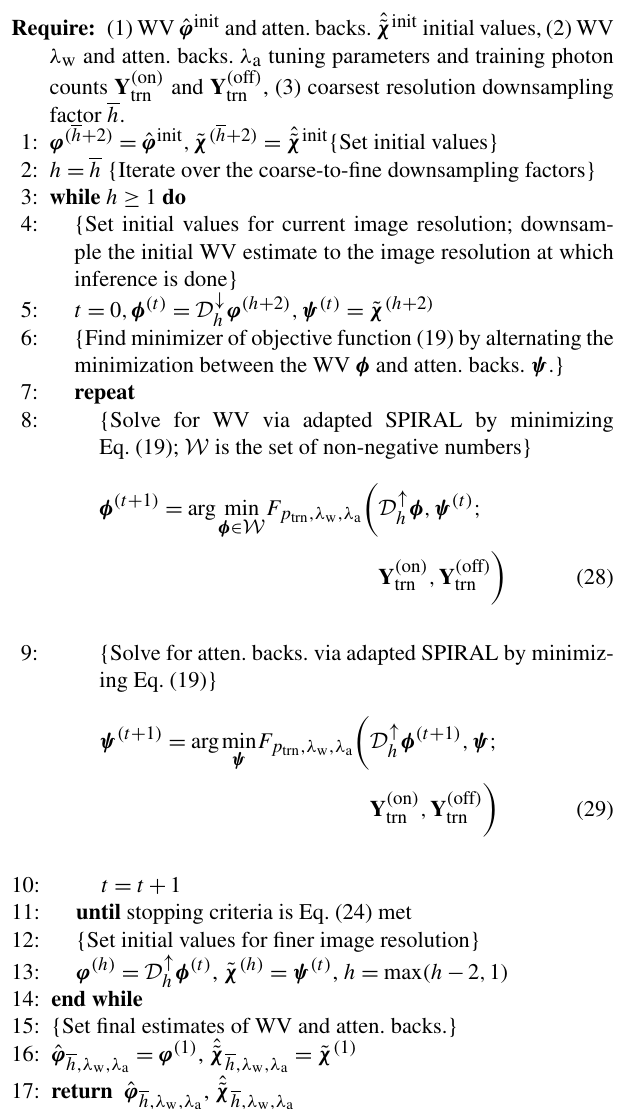
Algorithm 3 Cross-validation methodology in choosing op- timum tuning parameters when inferring WV ϕ and attenu- ated backscatter χ .